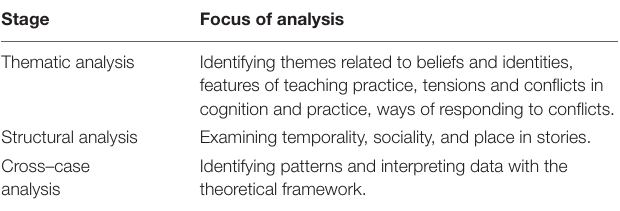
TABLE 2 | Three levels of data analysis and focus of analysis for each